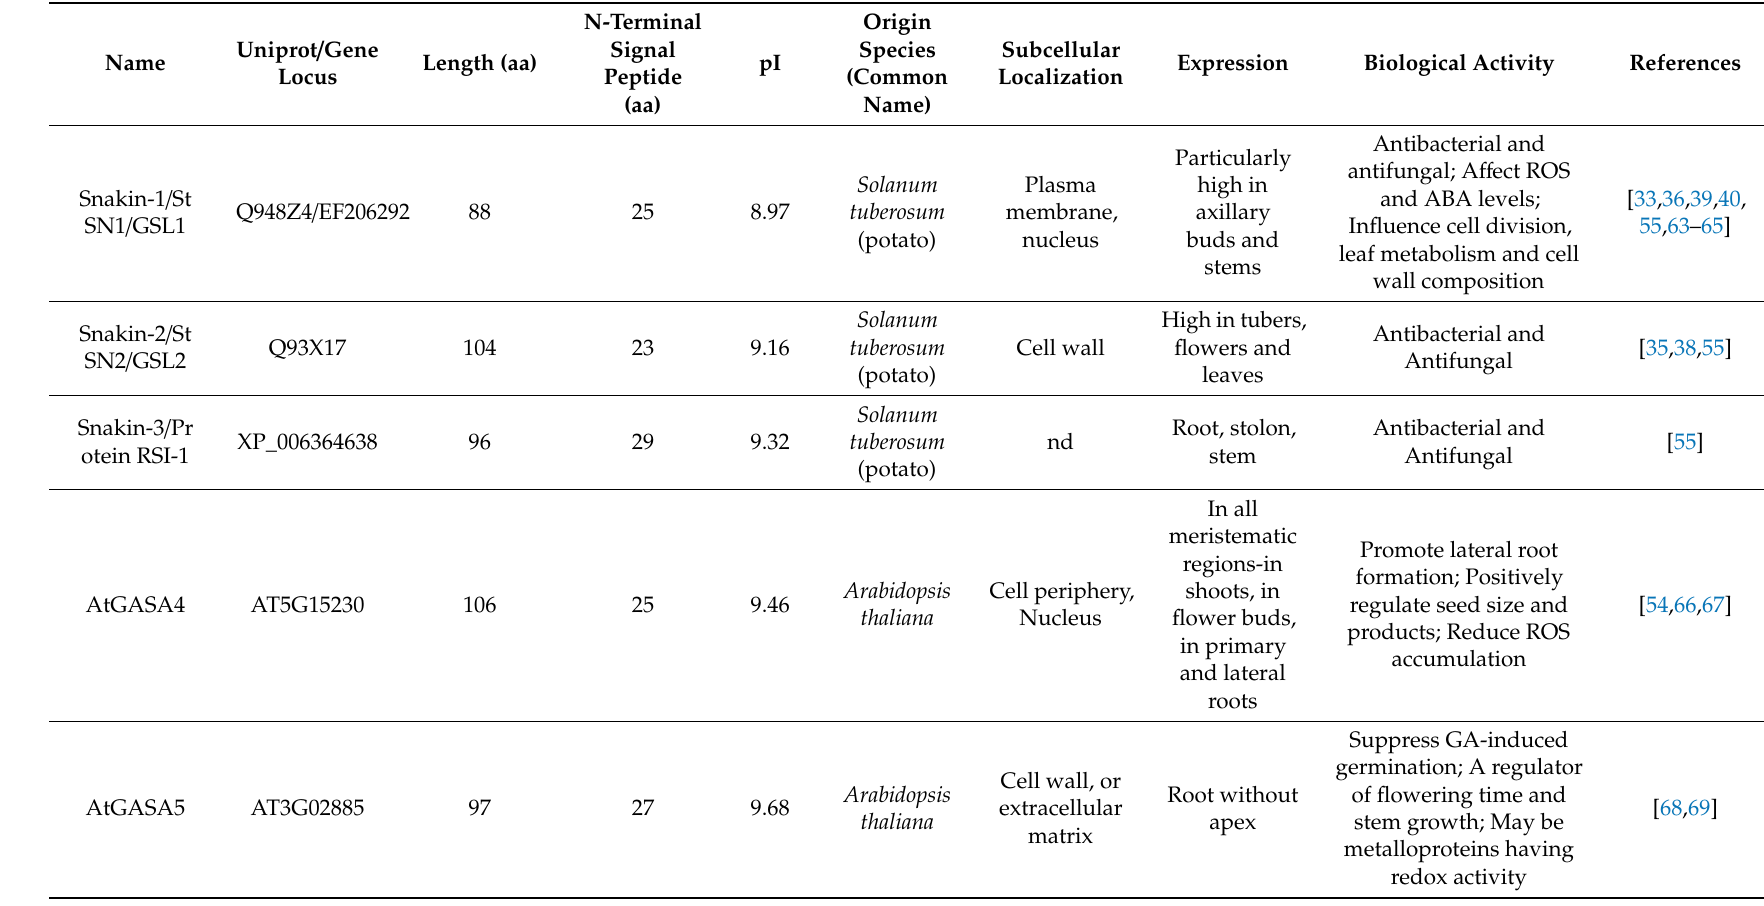
Table 2. Diversity of Snakin / GASA peptides of di ff erent